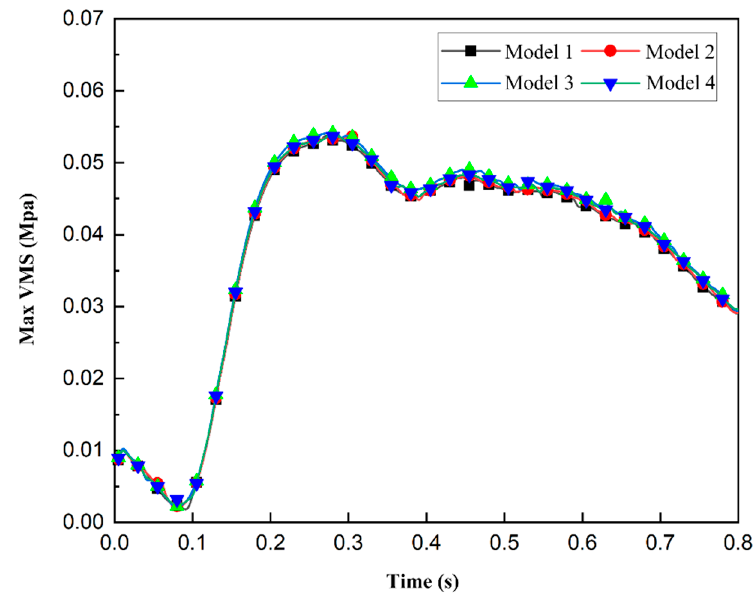
Figure 6. Curve of maximum VMS under a complete cardiac cycle.